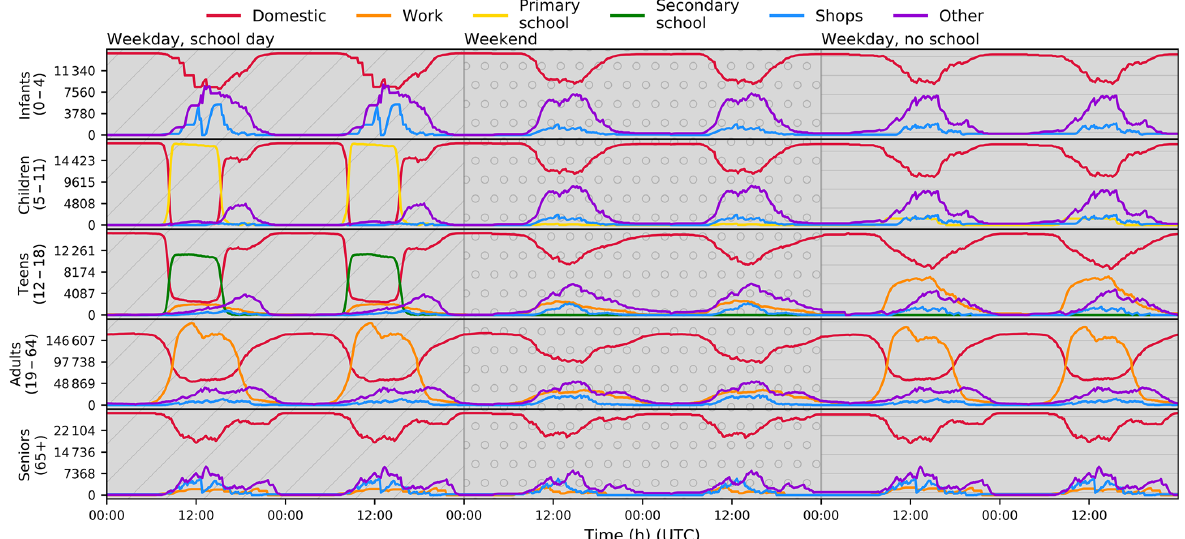
Figure 2. Total occupancy of each a N in one LA for five age groups across 6 consecutive days of three types (textured background): SW S (diagonal lines), WE (dotted), NS (horizontal lines) (R1, Table 6).